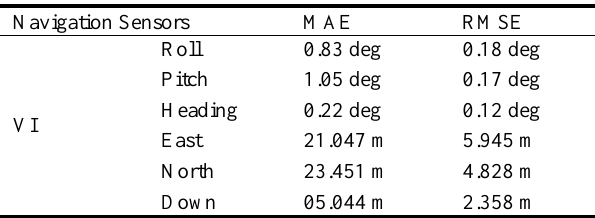
Table 3. The VI navigation system accuracy Navigation Sensors